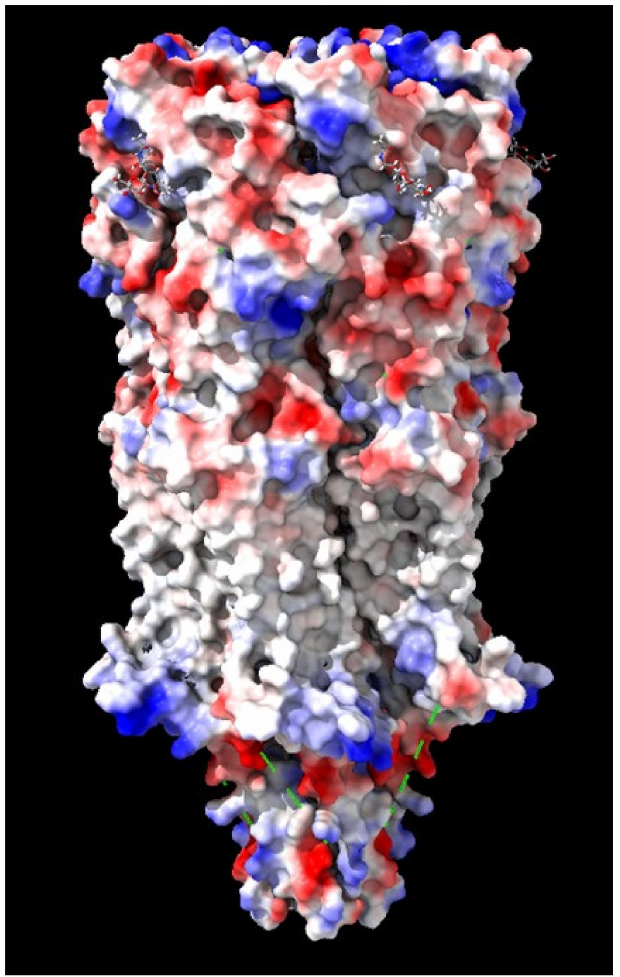
Figure 3. Reconstruction of the single-particle cryo-EM data of the homopentameric α 7 nAChR. The structure of the receptor protein resolved at 3.9 Å resolution by Noviello and coworkers [65] is shown in surface rendering. Two epibatidine molecules (ball-and-stick representation, and a third molecule partly seen at the top right) are seen bound to crevices in the extracellular domain of the nAChR. The receptor protein was fused to soluble cytochrome b562 to facilitate crystallization. PDB entry: 7KOQ; EMDataResource: EMD-22980. Image created using the software PyMol Molecular Graphics